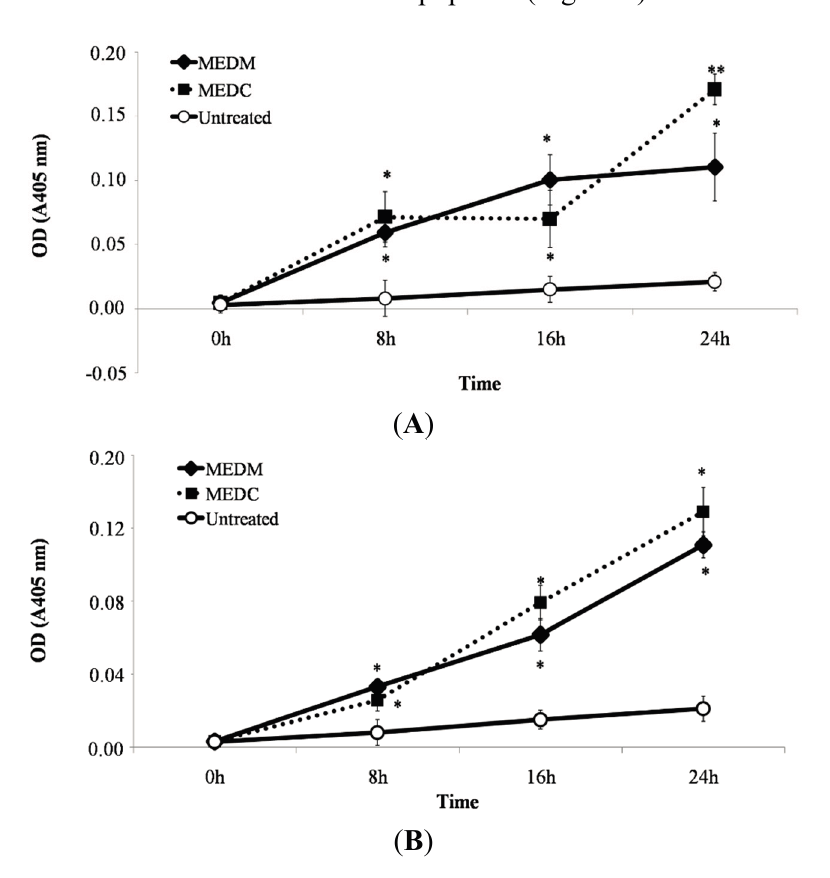
Figure 6. Effect of MEDM and MEDC on caspase-3 ( A ) and caspase-9 ( B ) activities in HeLa cells. The significance was determined by Turkey t-test (* p < 0.01 vs. negative control; ** p < 0.01 vs.